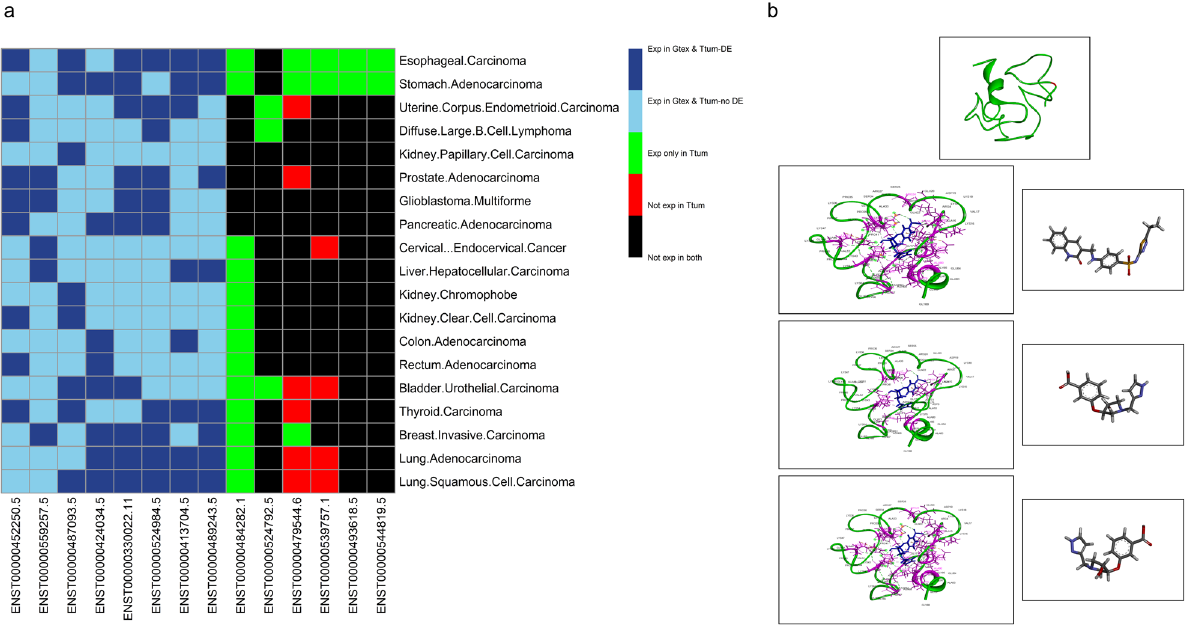
Fig. 6 nORFs dysregulated in cancer. a Analysis of Xena ’ s TCGA-TARGET-GTEx dataset to study the expression of the 14 probable ‘ cancer markers ’ which are expressed differentially in 19 cancers. These 14 markers are non-protein-coding transcripts that translate low-noise nORFs in 11 cell lines as observed from analyzing the ribo-ORF datasets from RPFdb (black — transcripts that are not expressed in both the tumor and matched normal samples; red — transcripts that are not expressed only in tumor samples; green — transcripts that are expressed only in tumor samples; light blue — no differential expression of transcript between the tumor and normal samples; dark blue — differential expression of transcript between the tumor and normal samples) (a transcript is de fi ned to be expressed if it has non-zero expression in at least 25% of